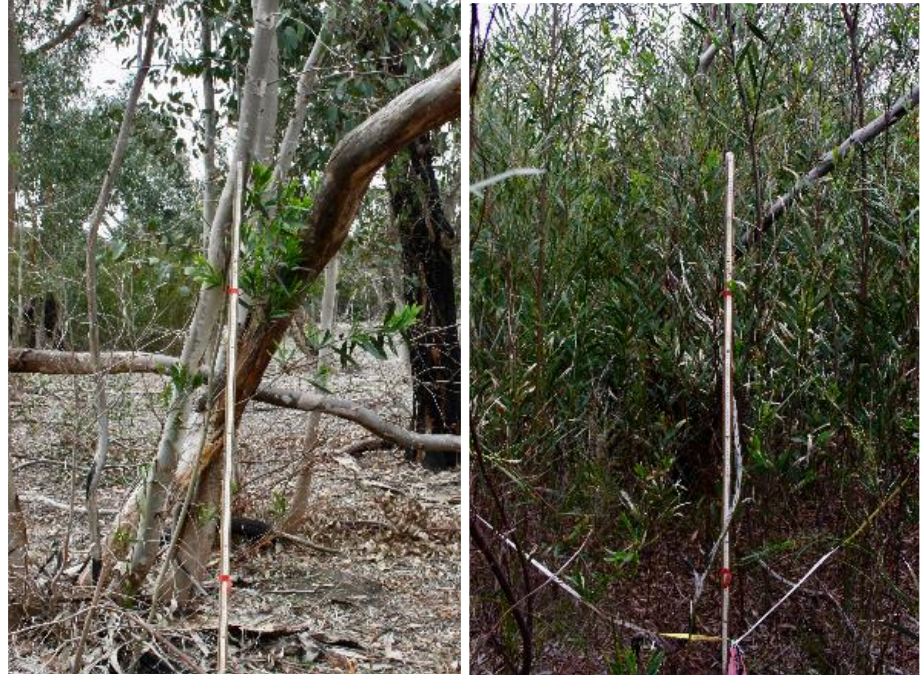
Figure 1. Paired plots with masticated ( left ) and control ( right ). Pohlners Rd site at the Grampians National Park masticated in 2018. Images feature a 2-m height pole. Photos taken in November 2018.